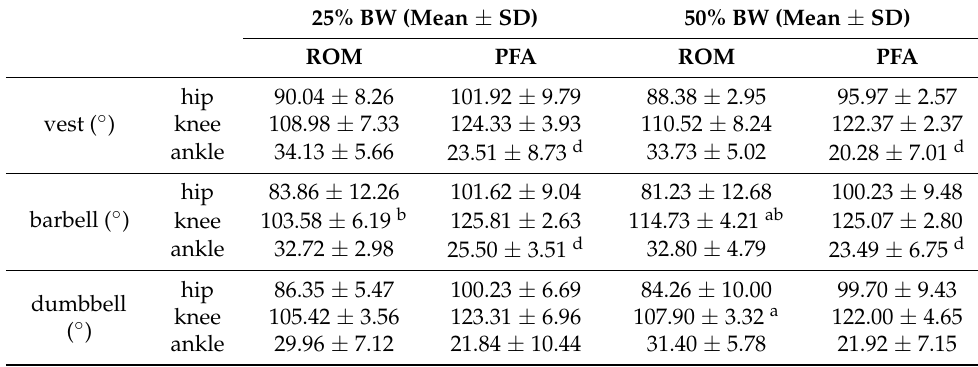
Figure 2. Joint angles and SPM1D results for hip, knee, and ankle at 25% BW and 50% BW. Red: indicates a significant difference between vest and barbell; green: indicates a significant difference between barbell and dumbbell. BW: body weight. Table 1. Sagittal ROM and PFA of the hip, knee, and ankle at 25% BW and 50% BW.